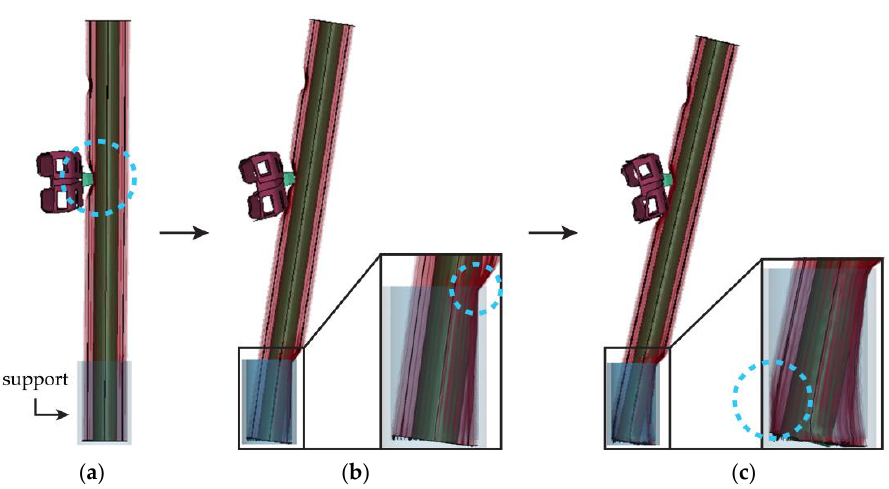
Figure 11. Simulation of in-plane honeycomb unit damage sequence: ( a ) at the initial impact; ( b ) honeycomb unit on the backside starts collapsing; ( c ) honeycomb unit at the bottom front side starts collapsing.